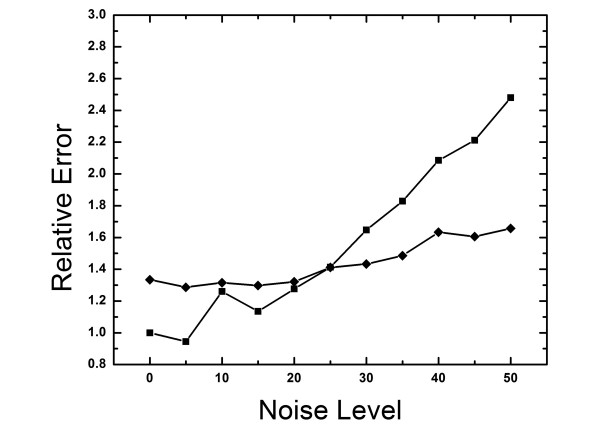
The sum of the square mismatch between the predicted and actual TF time course (relative to that obtained using noise-free microarray data) as a function of the amplitude of random noise added to the microarray data. The diamond and square markers represent the mismatch with and without the regularization constraint. For large noise levels the regularization constraint provides significant improvement in the calibration process.